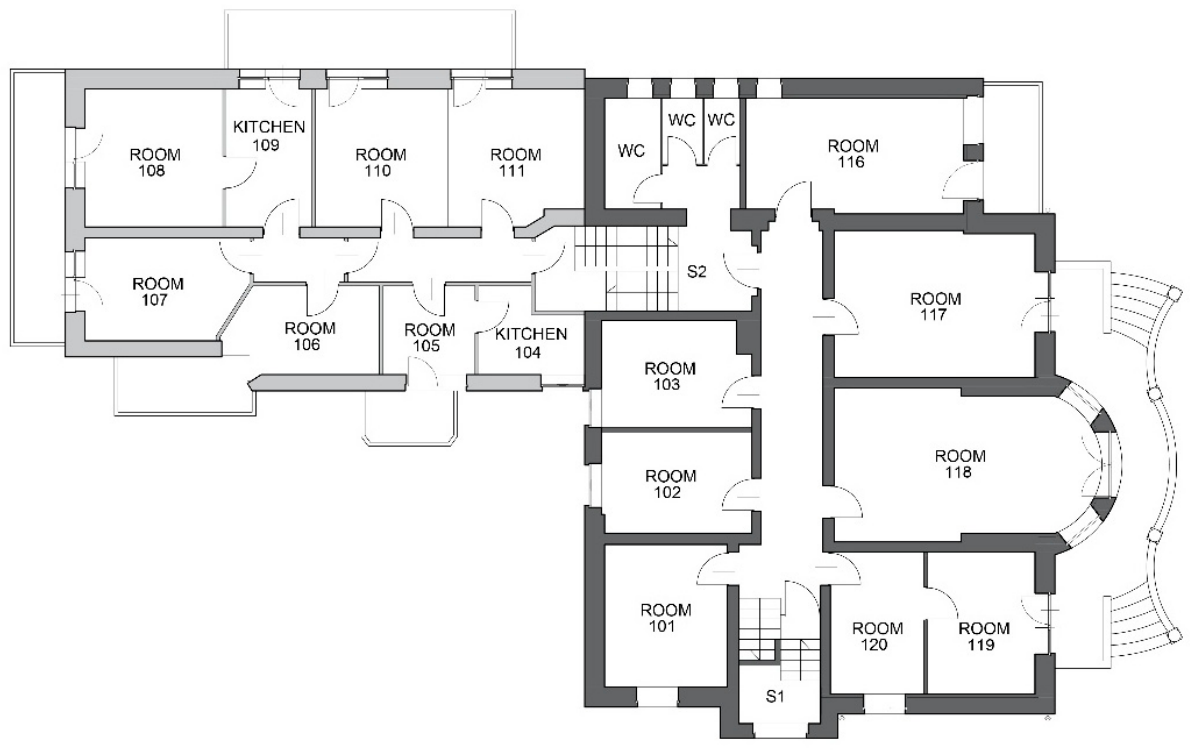
Figure 8. Willa Halina ground floor plan; building inventory 1999. Source: A. Taraszkiewicz.